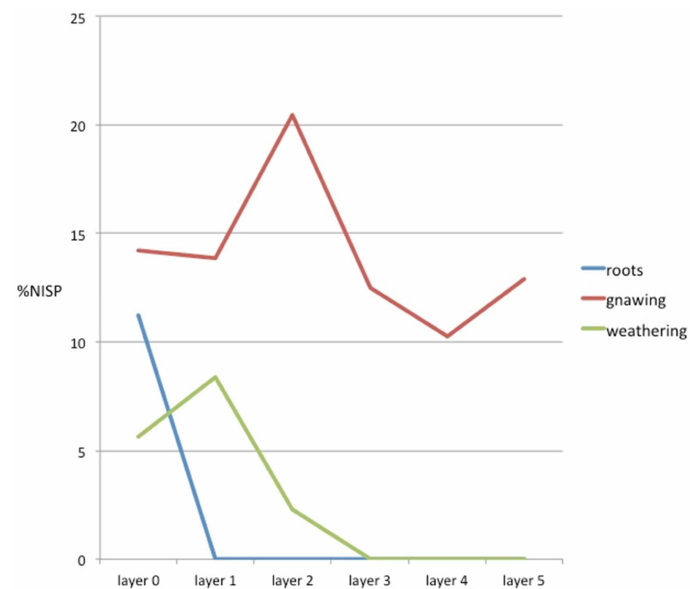
Figure 6. Number of natural modifications documented in the different layers of the Vilauba pit.